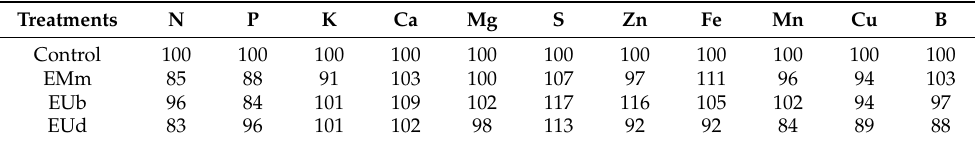
Table 3. Relative content (RC) (%) of the macro and micronutrients in leaves of the clonal eucalyptus hybrid I144 ( Eucalyptus urophylla × Eucalyptus grandis ) at 110